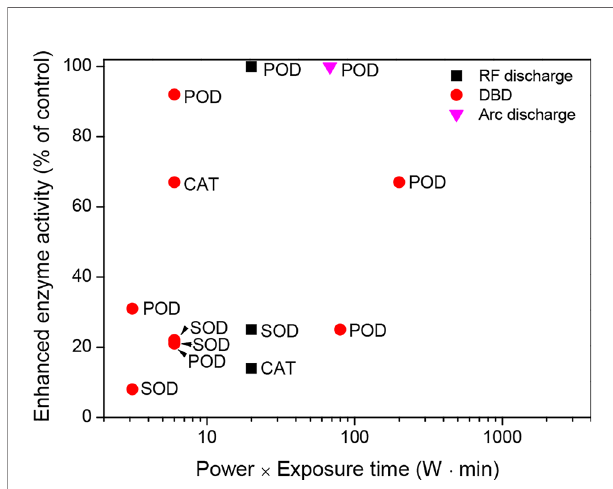
FIGURE 4 | Enhanced enzyme activity (% of control) as a function of the power (W) and exposure time (min) of the plasma treatments in seeds (or seedlings), which were described in the literature presented in Table 3